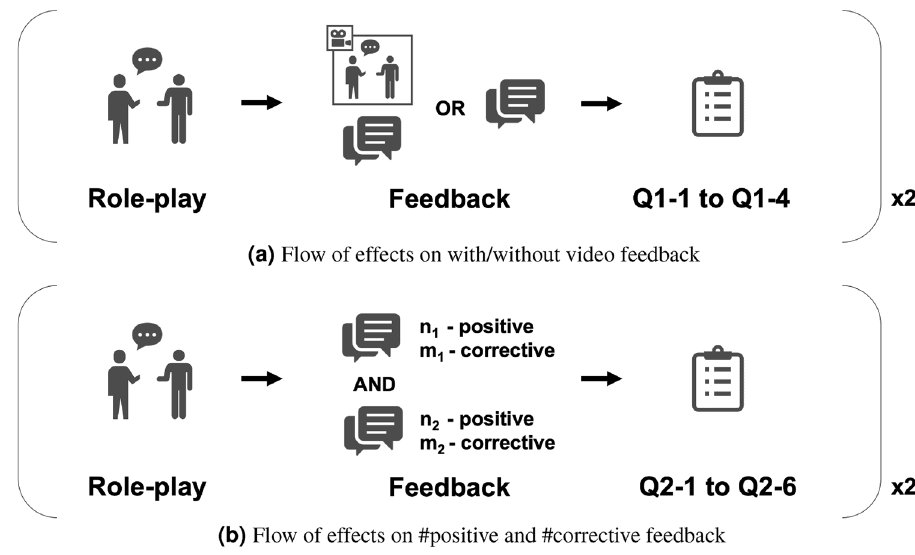
Figure 3. Flow of user-studies on feedback conditions.